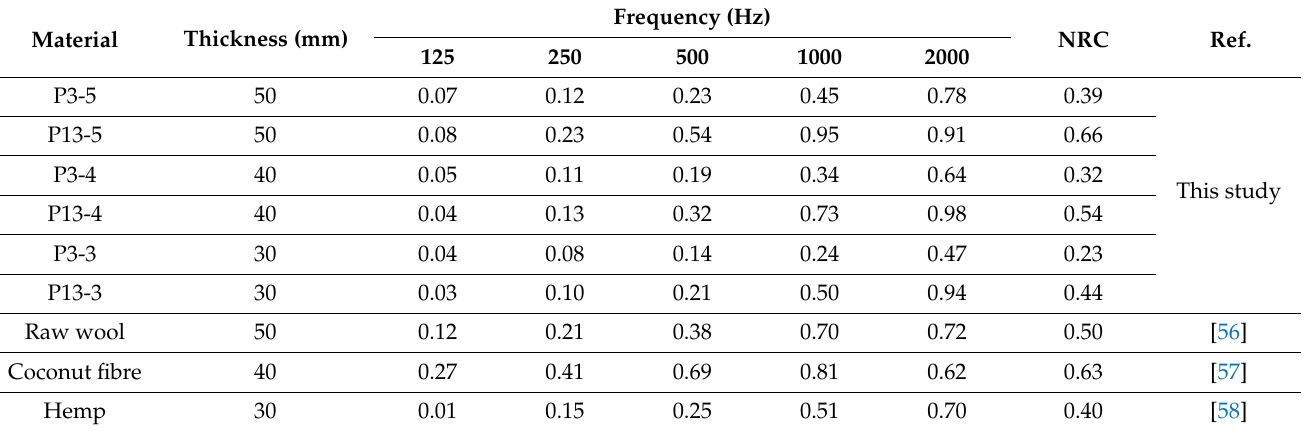
Table 6. Sound absorption coefficients as a function of frequency, and NRC values for different materials.